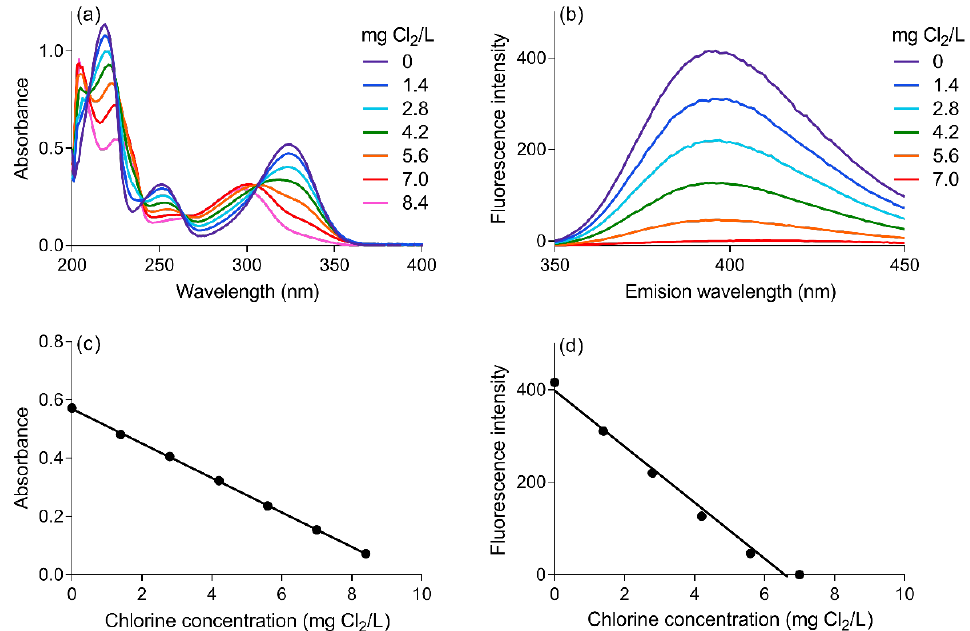
Figure 2. UV absorbance spectra ( a ) and fluorescence emission spectra with excitation at 330 nm ( b ) of pyridoxamine solution (100 µM, pH 7.0) dosed with different amount of chlorine. Linearity of absorbance at 324 nm ( c ) and fluorescence emission signal at λ ex = 330 nm and λ em = 396 nm ( d ) with chlorine addition to a solution of pyridoxamine (100 µM, pH 7.0). The R 2 was in both cases >0.998. Fluorescence intensity on vertical axis shown with arbitrary units.